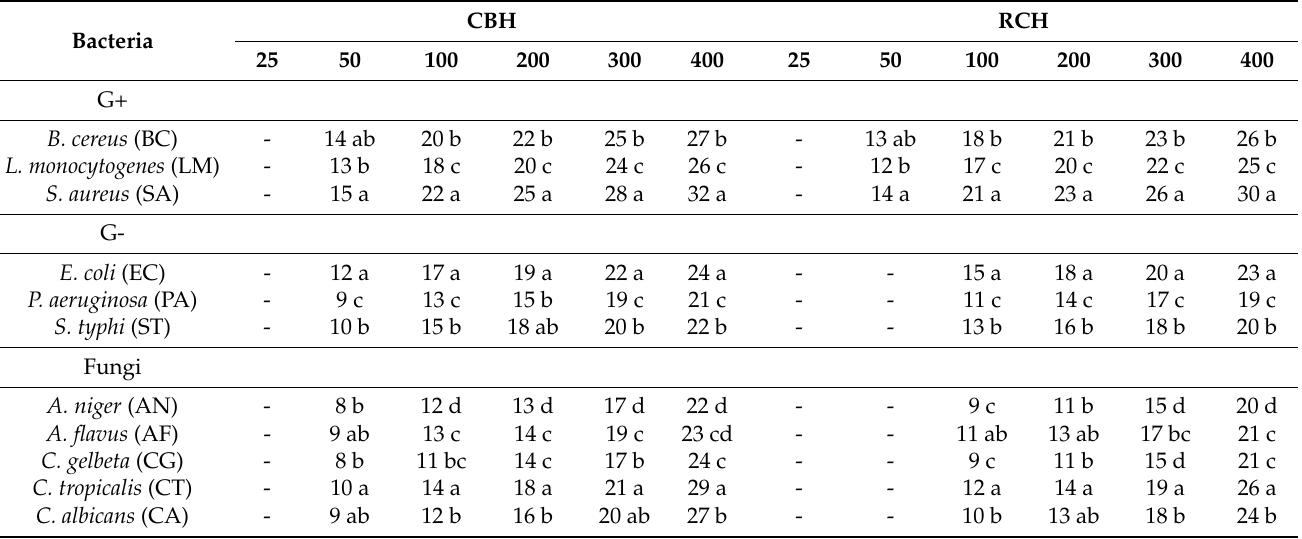
Table 3. The diameters of inhibition zones (mm) of CBH and CBH at different concentrations of 25–500 µ g/mL against Gram-positive, Gram-negative bacteria and fungi.